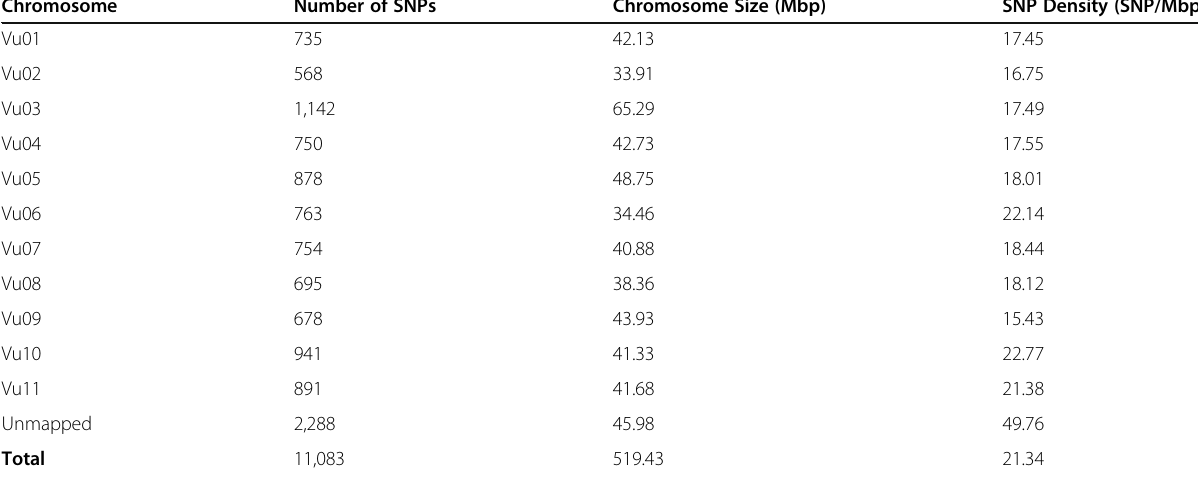
Table 1 Number of high-quality single nucleotide polymorphism (SNP) loci found by